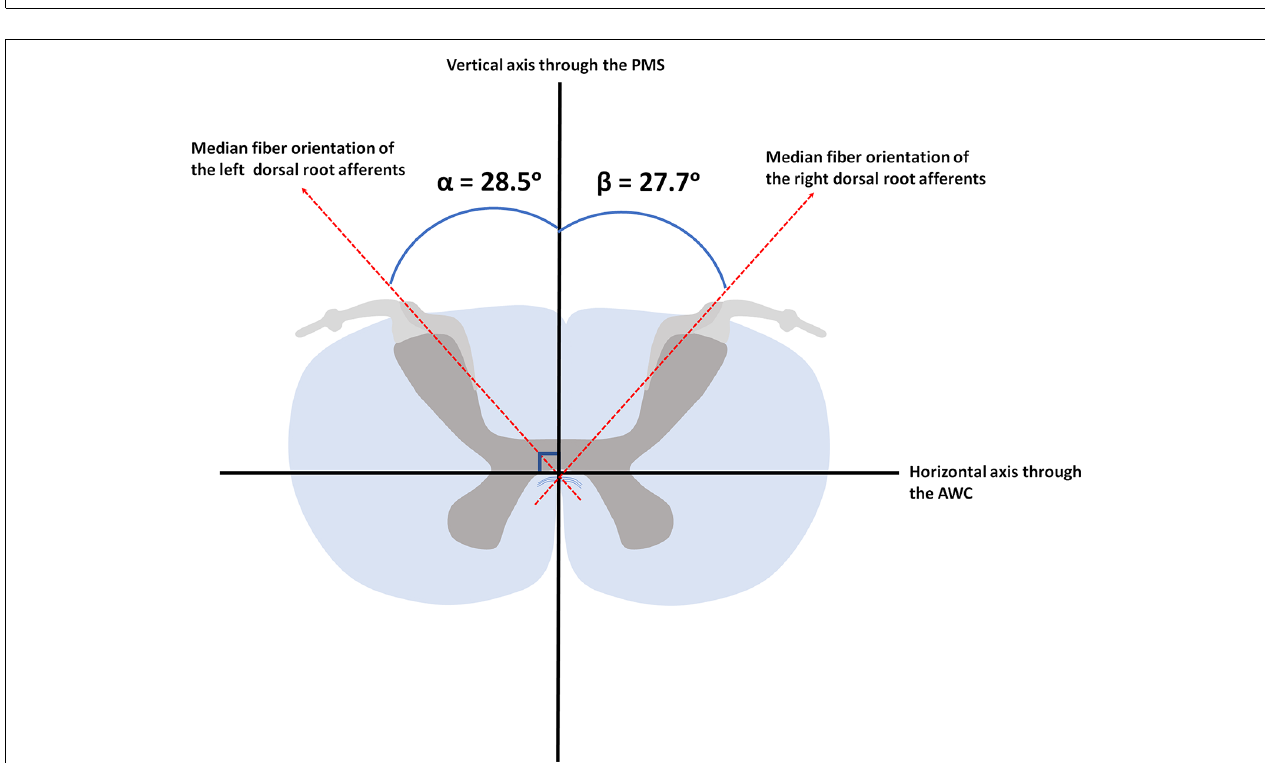
FIGURE 5 | Median orientation of the afferents within the left and right dorsal root. AWC, anterior white commissure; PMS, posterior median sulcus.